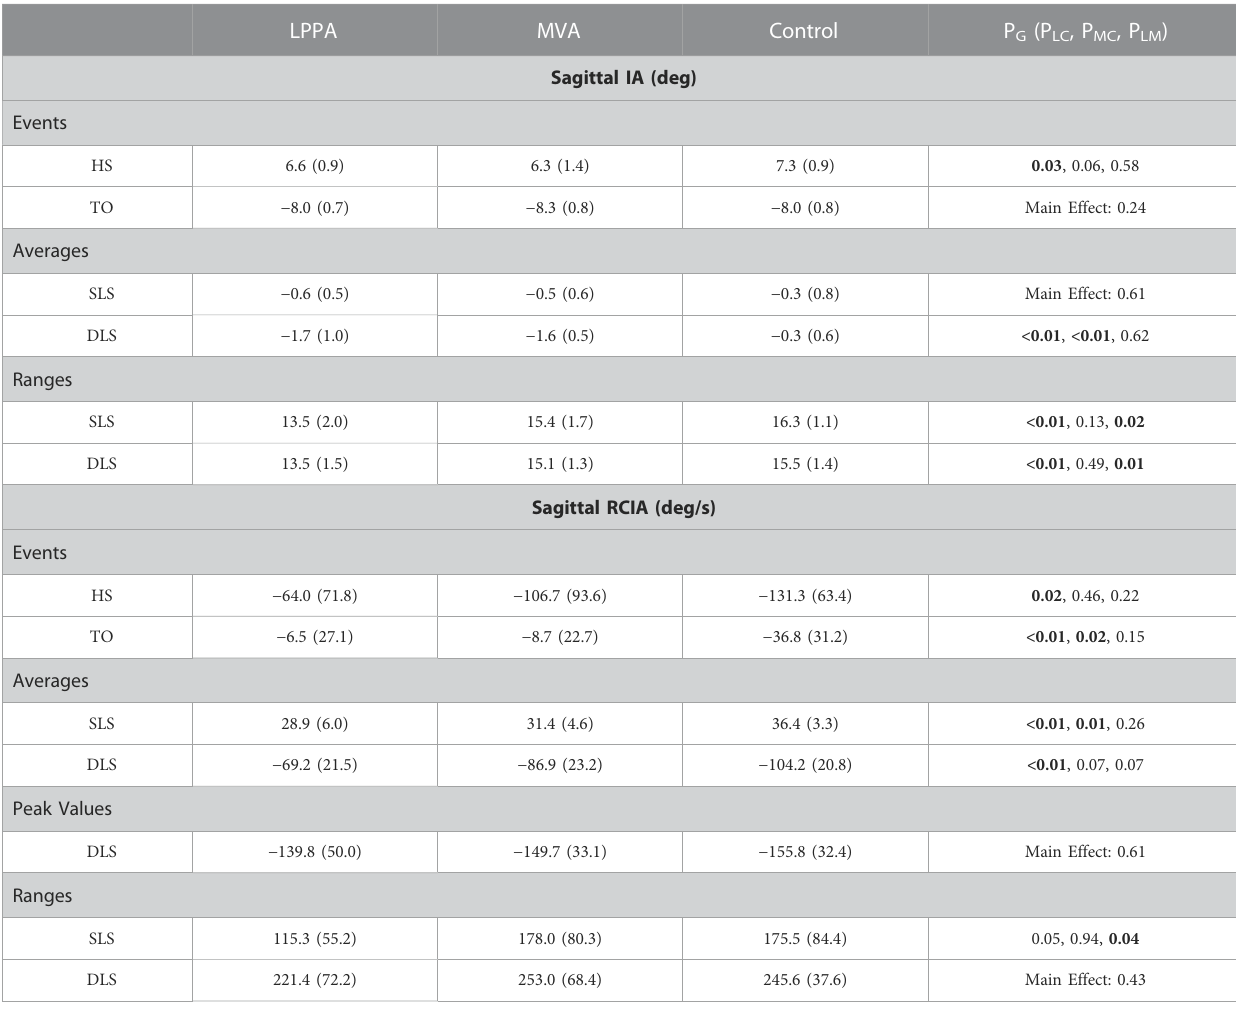
TABLE 2 Means (standard deviations) of inclination angles (IA) and rates of change of IA (RCIA) in the sagittal plane at heel-strike (HS) and toe-off (TO), and their average values and ranges during double-limb support (DLS) and single-limb support (SLS), as well as peak RCIA during DLS. p -values are also given for comparisons between groups using one-way analysis of variance (ANOVA) and for post hoc analysis using independent t